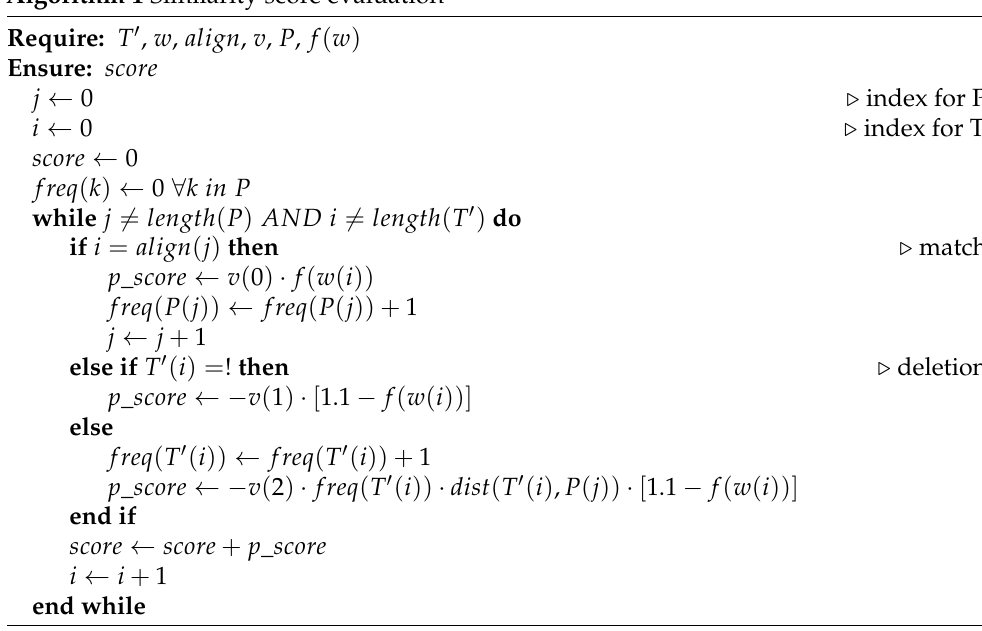
Algorithm 1 Similarity score